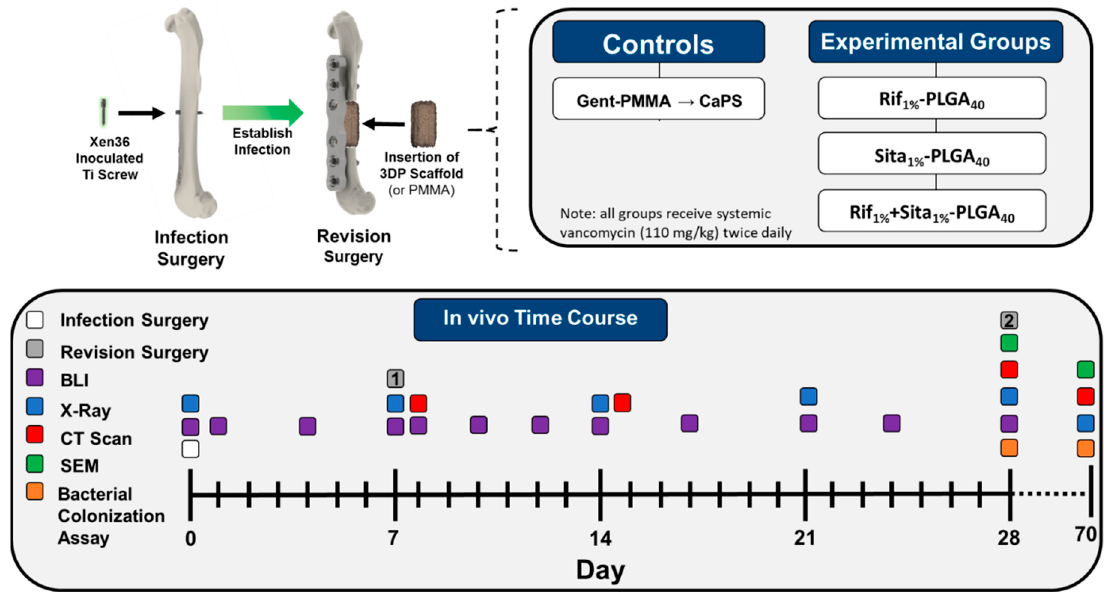
Figure 1. Schematic overview of the murine femoral ostectomy model used to assess 3D printed antibiotic-impregnated spacers for implant-associated osteomyelitis. First, a surgery was performed to establish an infection in the mouse’s femur. A titanium screw inoculated with bioluminescent Xen36 (~2.5 × 10 6 CFU/mL) was inserted in the mid-diaphysis of a 13–15-week-old female Balb/cJ mouse. The infection was established for 7 days and then a revision surgery was performed in which the contaminated screw was removed and the femur was stabilized with a polyether ketone (PEEK) plate with 4 titanium screws. A 3-mm ostectomy is then performed to debride the infected mid-diaphysis of the femur. A poly(methyl methacrylate) (PMMA) cement spacer impregnated with gentamicin (1.25 wt %; Cobalt MV) or a 3D printed calcium phosphate scaffold (CaPS) with incorporated rifampin, sitafloxacin, or both is then inserted into the defect. Relapse in infection is continually monitored via bioluminescent imaging on days 1, 3, 5, 7, 12, 14, 17, 21, 24, and 28 days post-revision. The mouse was then euthanized 3 weeks post-revision surgery and the hardware, bone, cement spacer, and surrounding soft tissue is harvested for CFU analysis. N = 8/group. Long-term bone healing was also assessed 10 weeks post-revision in an identical cohort. In this study, the clinical control utilizing Gent-PMMA underwent a second revision surgery 3 weeks after the PMMA insertion, in which the Gent-PMMA spacers were removed and a 3D printed CaPS was inserted. Bone healing was assessed for 10 weeks post-revision. N = 8/group.